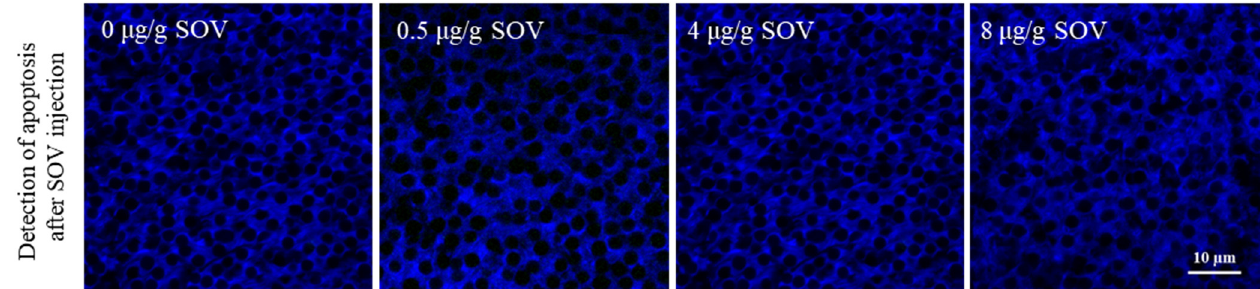
Figure 5. Apoptosis detection. No obvious signal (FITC, green fluorescence) was detected after injection of different concentrations of SOV in testis.